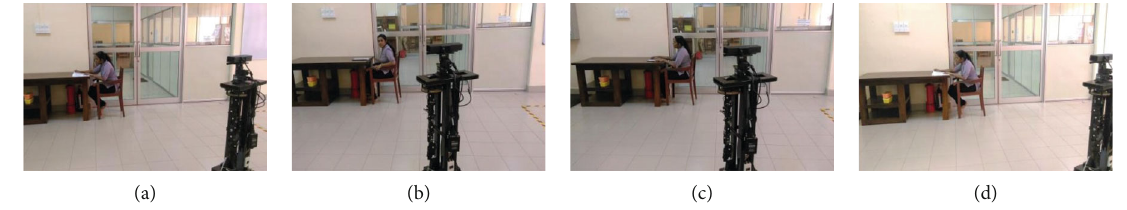
Figure 3: An application of the two theories: occasion 2 (a), user was working and has no idea about the presence of the robot, (b) notices the presence of the robot as it moves and looks at the robot, (c) user averts her gaze and give attention to the work, and (d) engage in the work